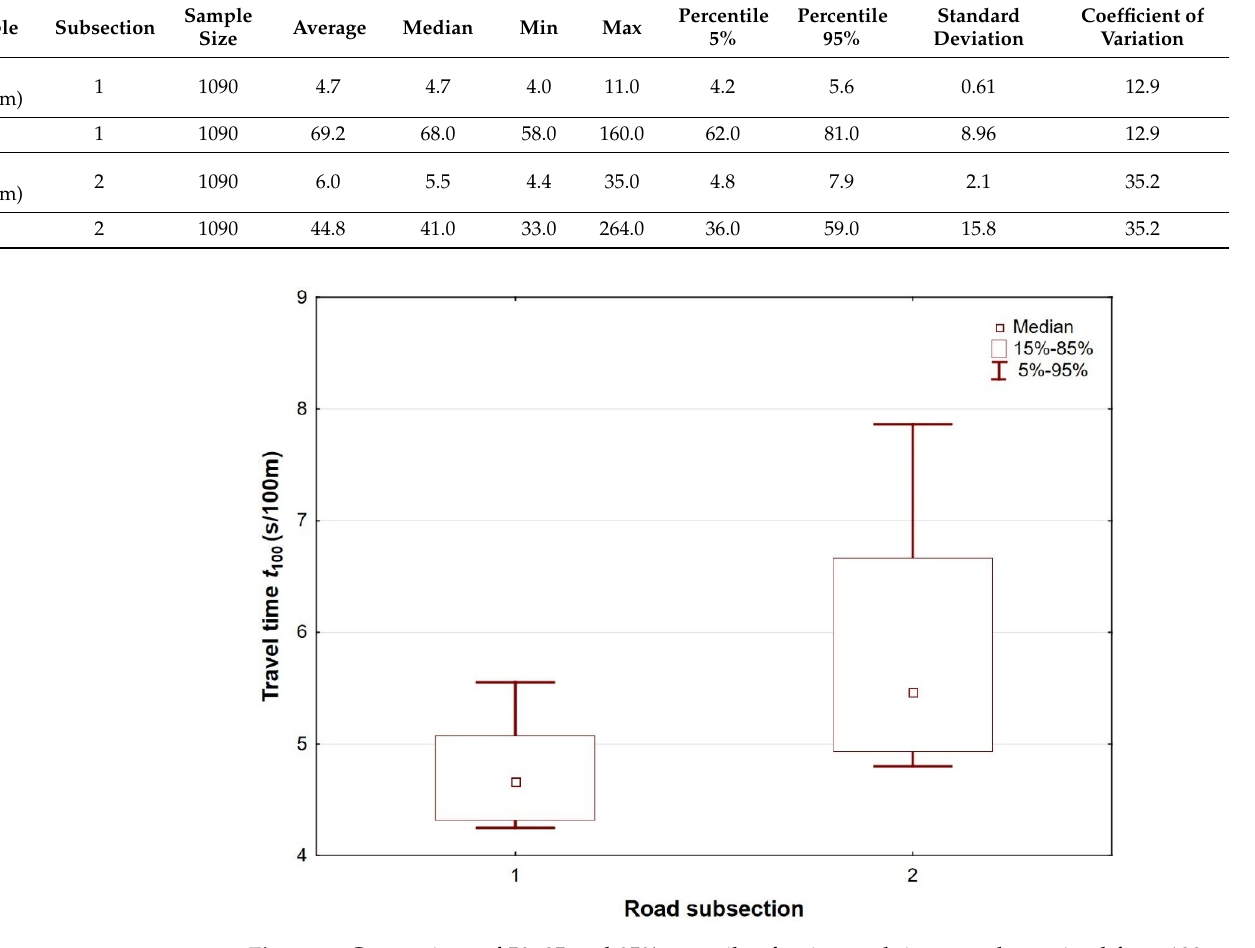
Figure 9. Comparison of 50, 85 and 95% quantile of unit travel time t 100 determined for a 100 m length of subsections 1 and 2.